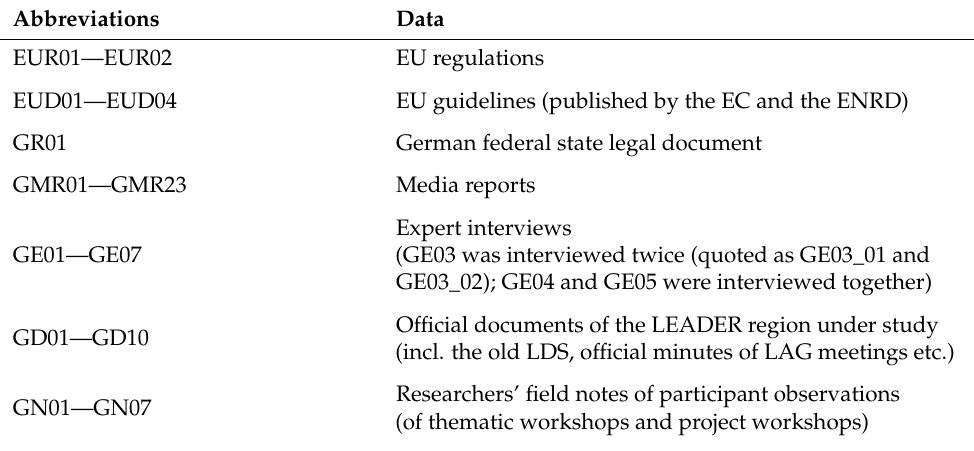
Table 1. Overview of analyzed data (Explanations: EU = Europe; G = Germany; R = Regulation; D = Document; E = Expert interview; N = Notes taken by researchers; MR = Media